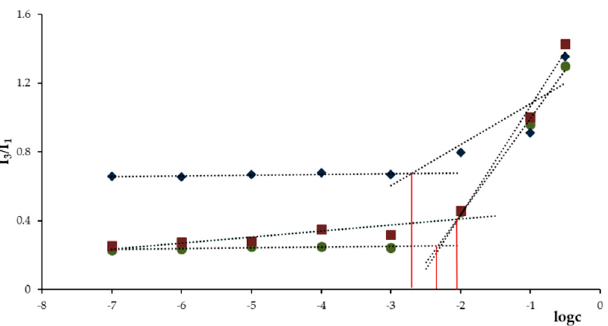
Figure 4. Dependence of pyrene fluorescence spectrum signals on ( ● ) DEXFA, ( ♦ ) DEXssPEGCOOH, and ( ■ ) DEXFA/DEXssPEGCOOH concentration at pH 7.4.